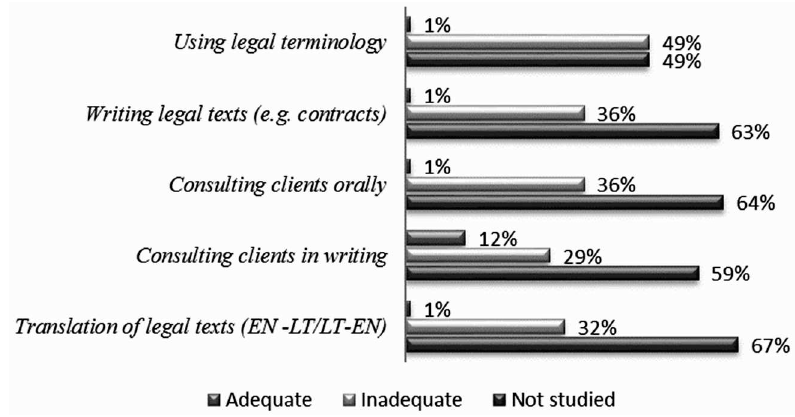
Figure 5. Self-assessment of communicative skills and competences in Legal